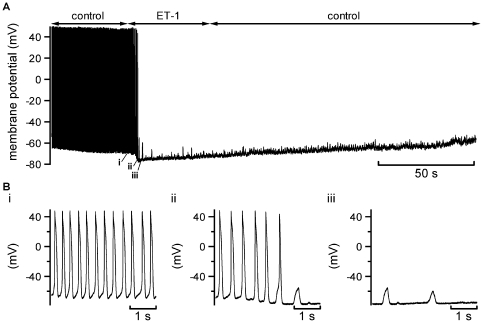
Effects of ET-1 on spontaneous APs.A. Slow time-base recording of APs before, during and after rapid application of 10 nM ET-1. B. Expanded (faster time-base) portions of the recording extracted from numbered sections of panel A (indicated labels i, ii, iii). Similar results were observed in 9 experiments.